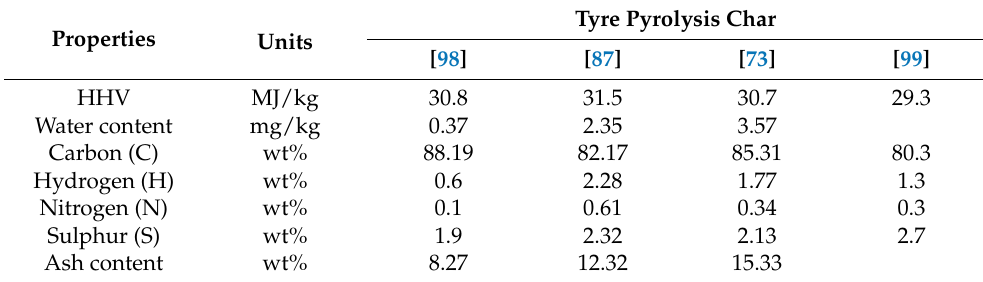
Table 3. Properties of waste-tyre